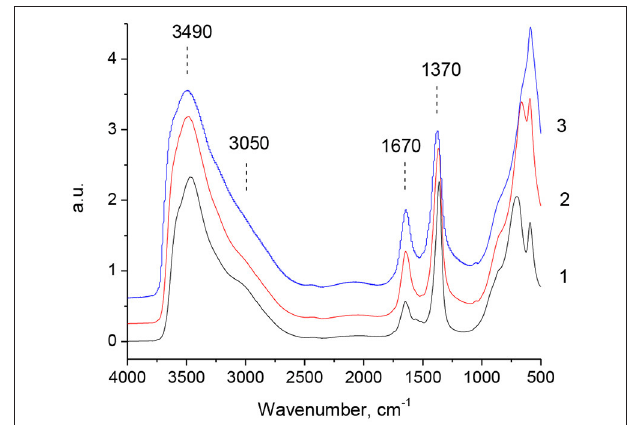
FIGURE 6 | DRIFT spectra for reconstructed MgGa-2R10 (1), MgGa-3R10 (2), and MgGa-4R10 (3).